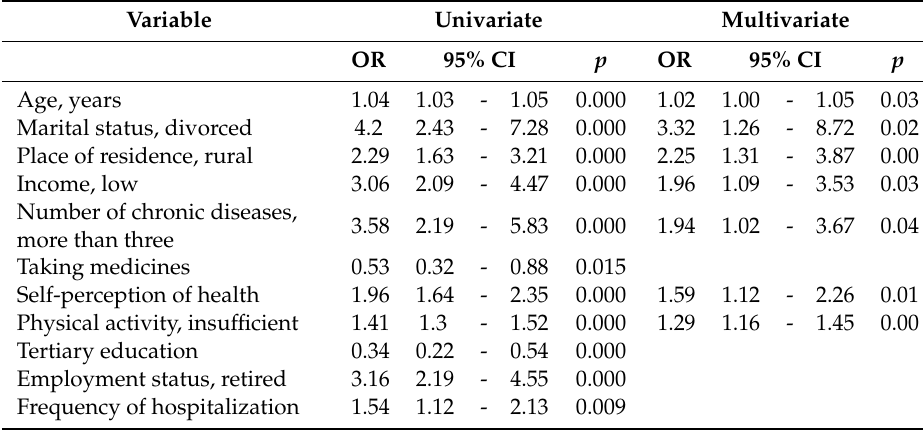
Table 3. Factors associated with health illiteracy according to S-TOFHLA score (adequate versus marginal and inadequate)—multivariate logistic regression